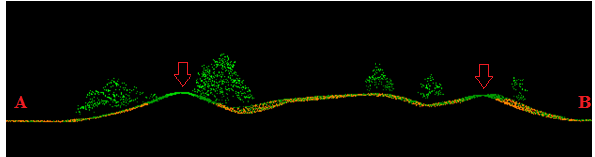
Fig. 7. Elevation profile of vegetation A-B – object 1